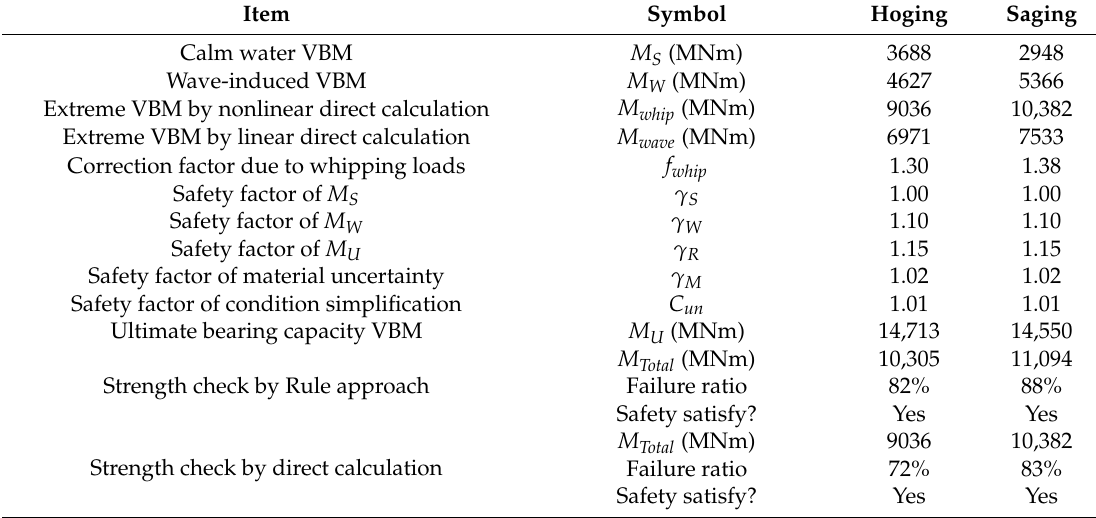
Figure 23. The calculated curve of VBM versus curvature. Table 5. Hull girder ultimate strength assessment